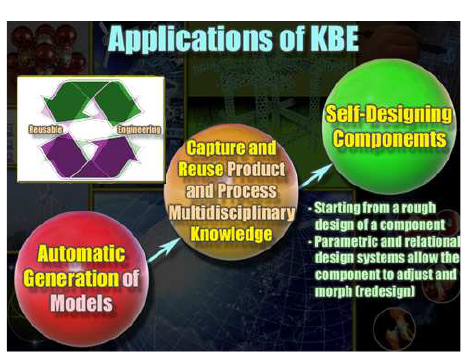
Figure 3. Basic Components of Material Informatics. Figure 4. Past and current applications of KBE.